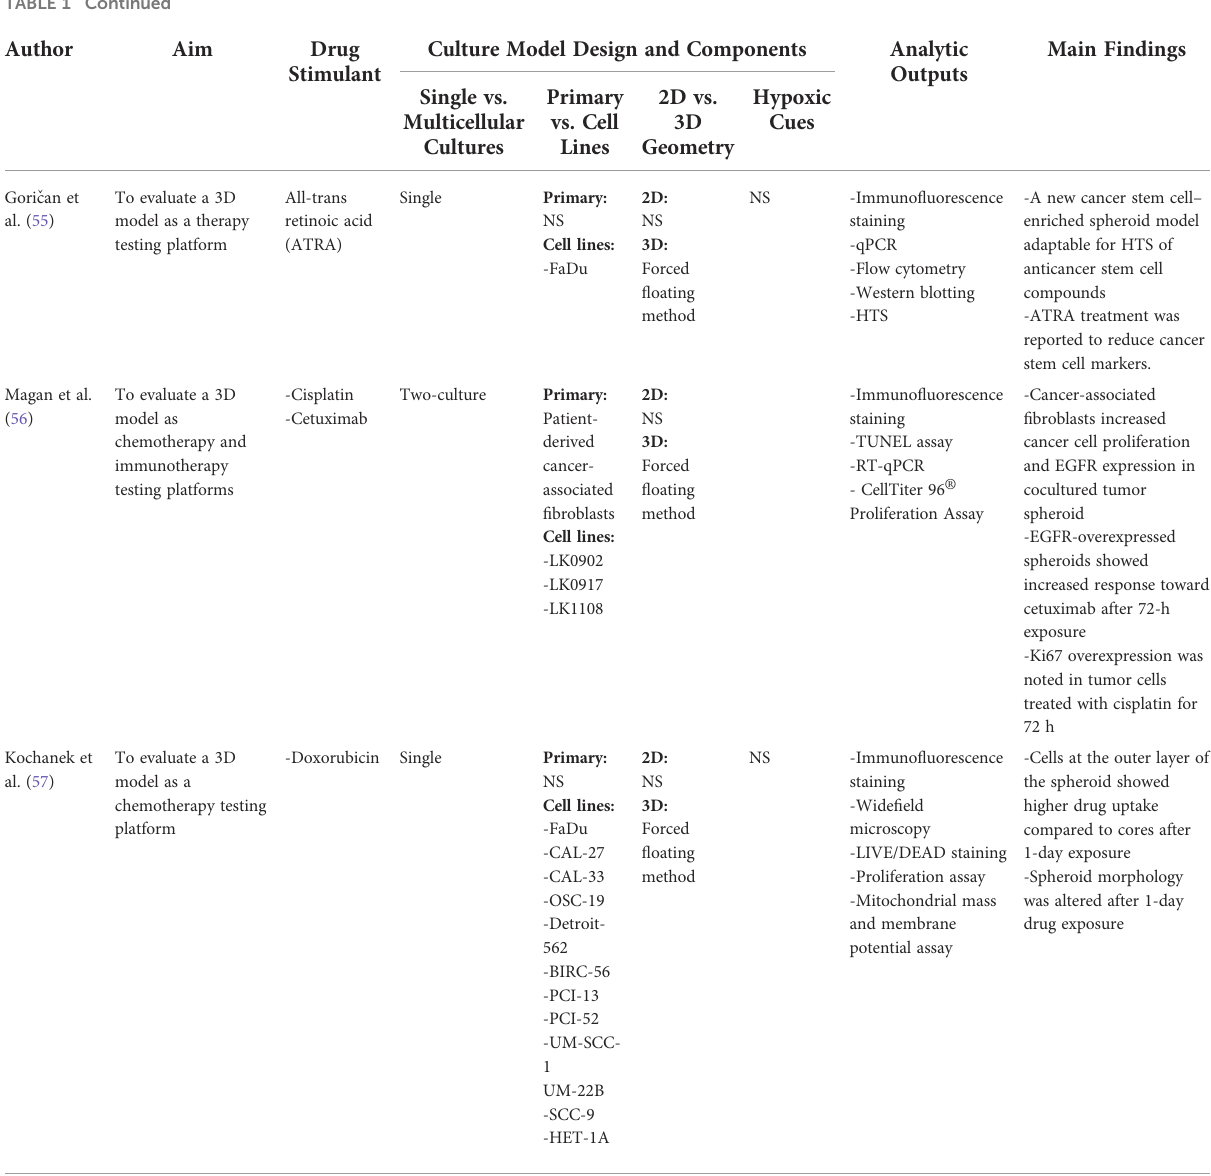
(Figure 5). A 3D scaffold-based in vitro model aims